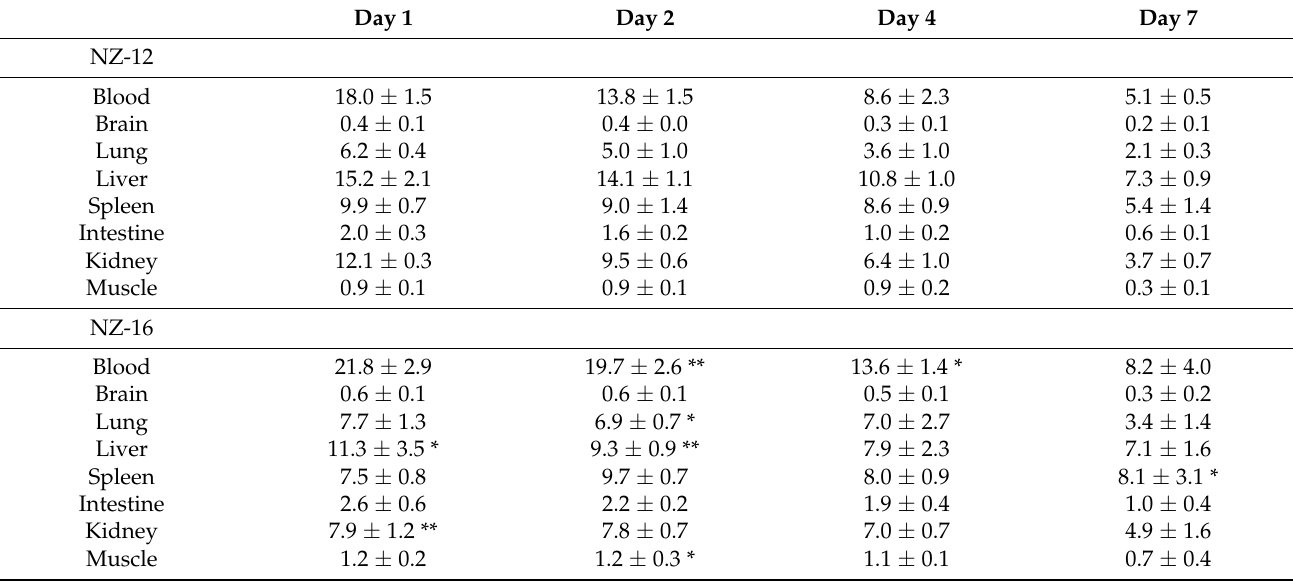
Table 1. Biodistribution of 111 In-labeled antibodies in H226 tumor-bearing mice.